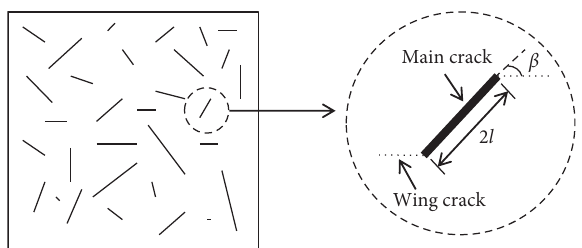
Figure 4: Statistical parameters of the main and wing microcracks in rocks. l : the half-length; β : angle between the direction of crack and horizontal direction.